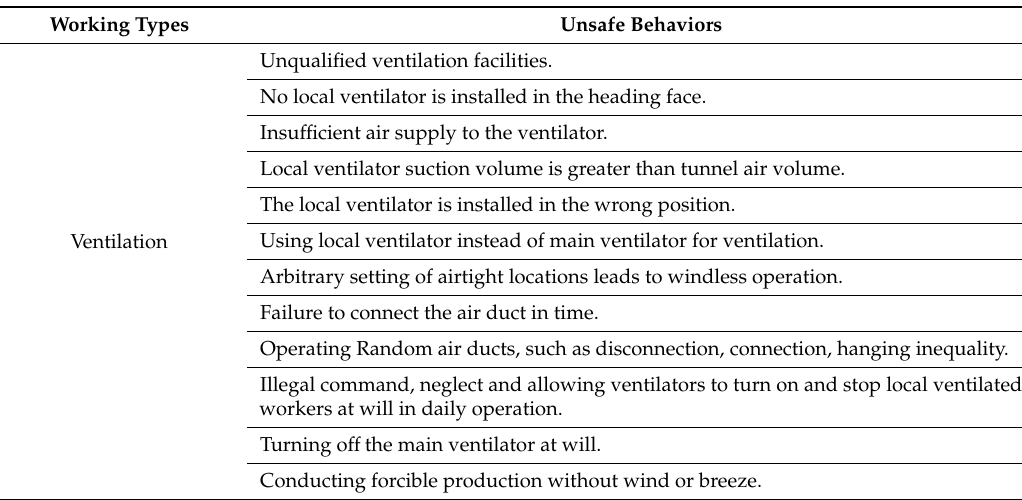
Table 2. Influencing factors of unsafe behaviors in key working